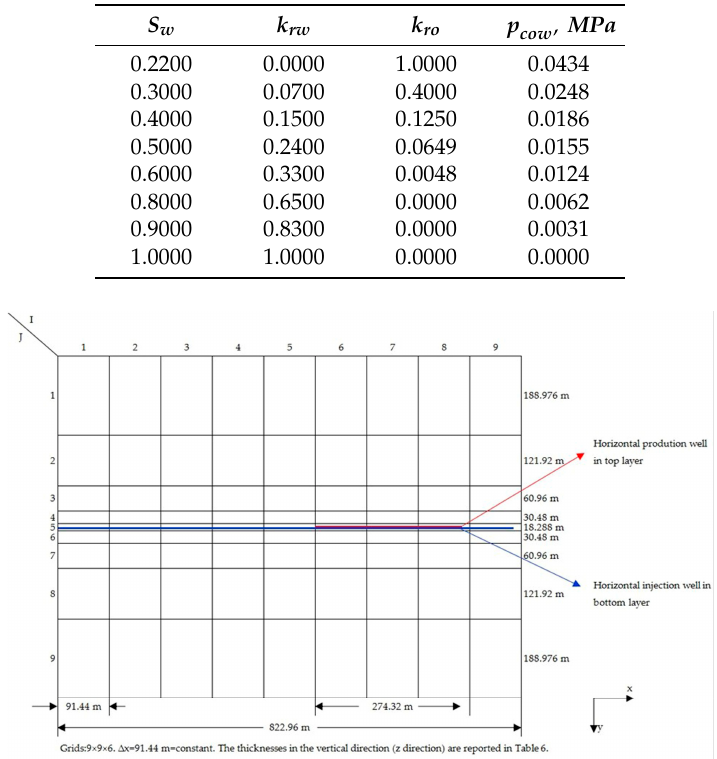
Figure 12. Grids system and well location of the case.